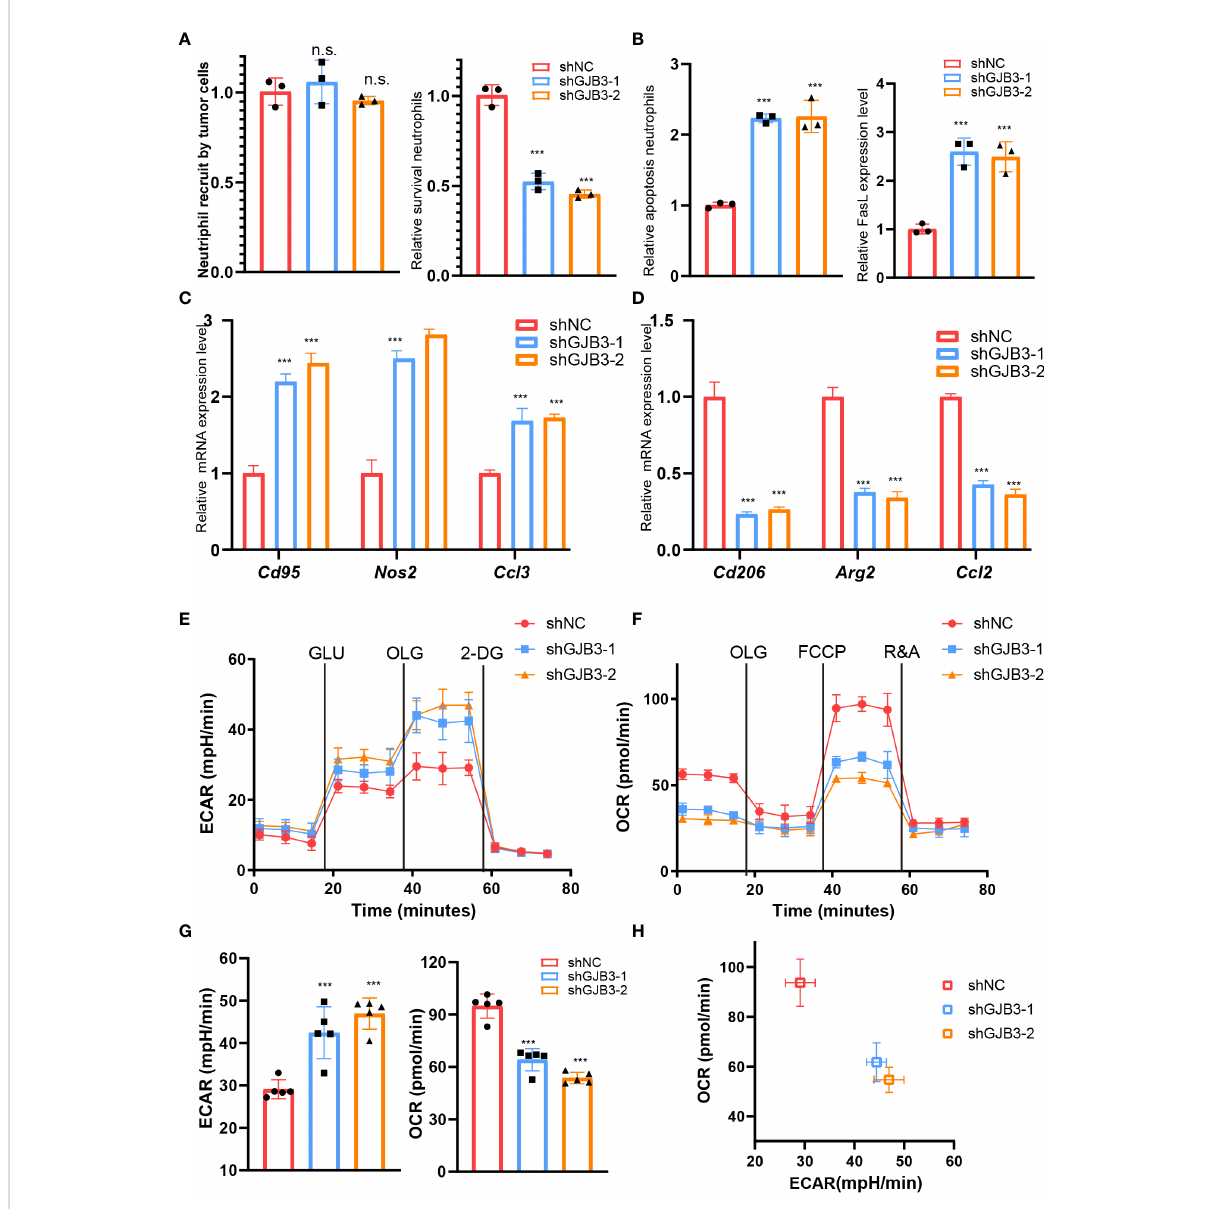
FIGURE 4 GJB3 facilities neutrophil polarization and survival (A) . The relative Cd95 , Nos2 and Ccl3 mRNA expression level in neutrophil which co-cultured with shNC, shGJB3-1 and shGJB3-2 KPC1199 cells. N1- like maker genes. (B) . The relative Cd206, Arg2 and Ccl2 mRNA expression level in neutrophil which co-cultured with shNC, shGJB3-1 and shGJB3-2 KPC1199 cells. (C – E) . The extracellular acid rate measurement and oxygen consumption rate measurement of neutrophil which co-cultured with shNC, shGJB3-1 and shGJB3-2 KPC1199 cells (n = 5). (F) . The metabolism phenotype of neutrophil which co-cultured with shNC, shGJB3-1 and shGJB3-2 KPC1199 cells. (G) . The neutrophil recruitment by shNC, shGJB3-1 and shGJB3-2 KPC1199 cells (n = 3). (H, I) . The survival and apoptosis neutrophil upon co-cultured with PDAC cells (n = 3). (J) . The relative FasL expression level in neutrophil. Data presented as mean±standard deviation. ***P<0.001. ns, no signi fi